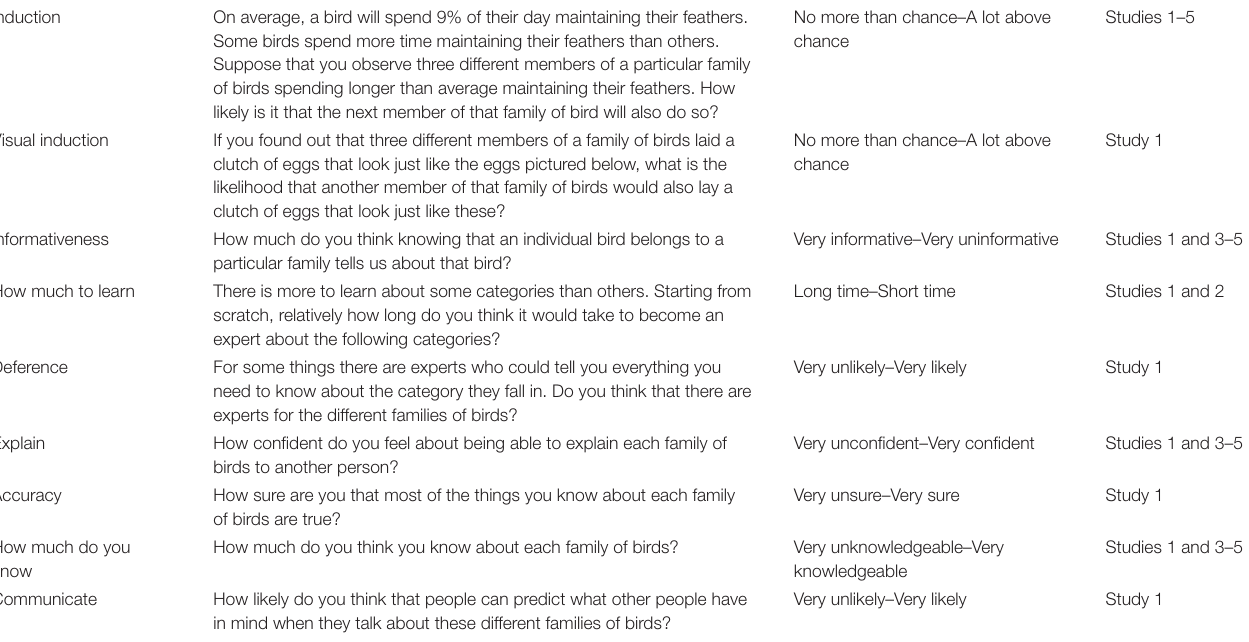
TABLE 1 | Nine concept appraisal questions used in Studies